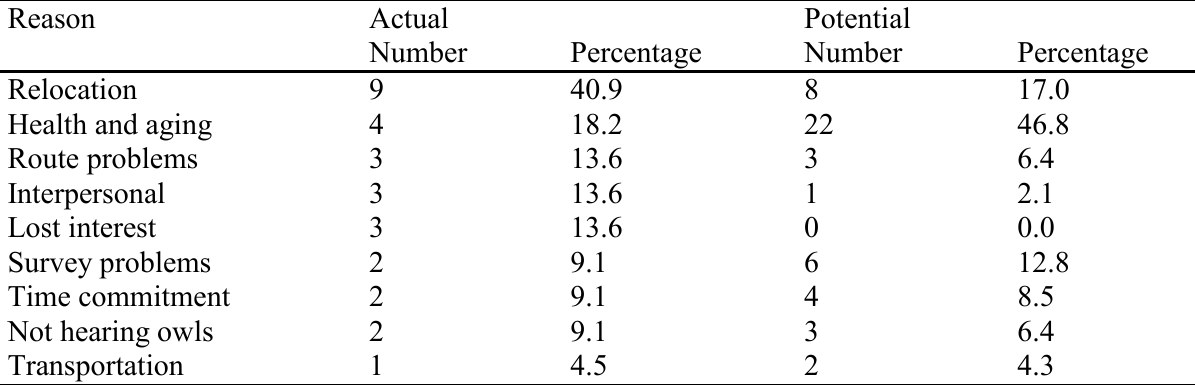
Table A2.1. Actual reasons cited by ex-participants ( n = 22) and potential reasons cited